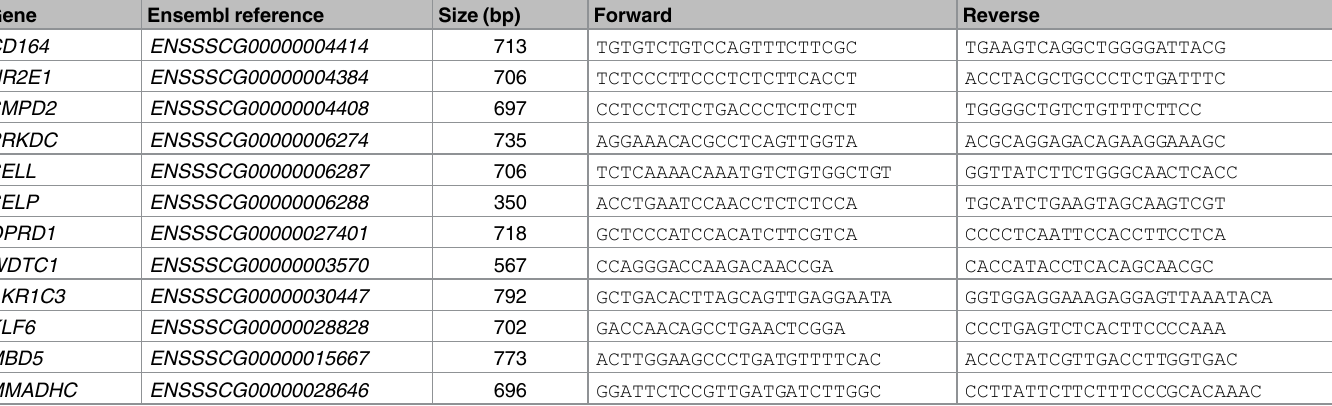
Table 1. Forward and reverseprimers for PCR amplification of the twelve selected positional candidate genes located within 1Mb of the genome- wide significant markersfor EBVs FCR and D110.